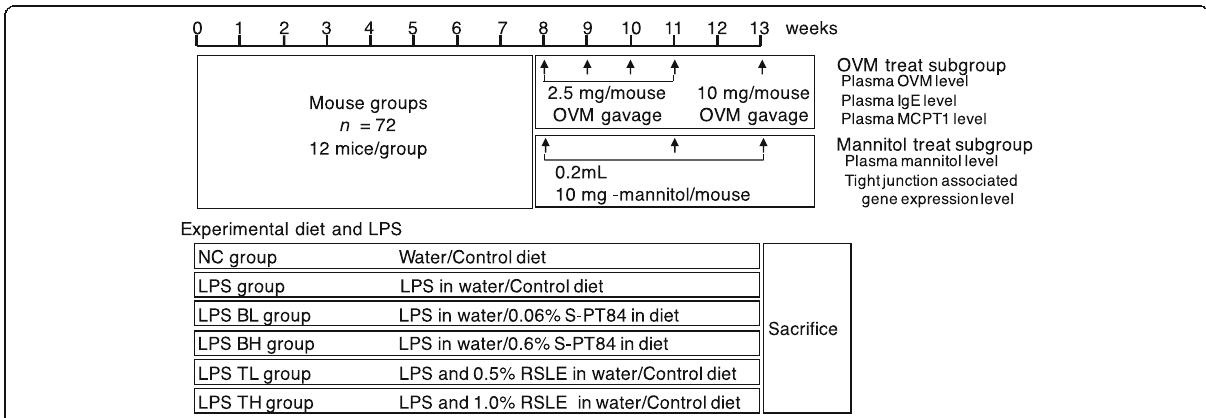
Fig. 1 Outline of the animal experiment design. Mice were divided into 6 groups ( n = 12 mice/group). Mice were fed S-PT84 or RSLE for 13 weeks. LPS containing water (1.5 μ g/mL) fed for 13 weeks excepting negative control group. The half of each group ( n = 6) was fed ovomucoid (OVM) 4 times at 8, 9, 10, and 11 weeks except negative group, respectively. At 13 weeks, the mice were challenged orally with OVM (10 mg/ mouse). Two hour later mice were sacrificed for collection of blood. The other half of mice were (n = 6) fed D-mannitol at 8, 11 and 13 weeks, and 2 h later of end point, mice were sacrificed for collection of blood and